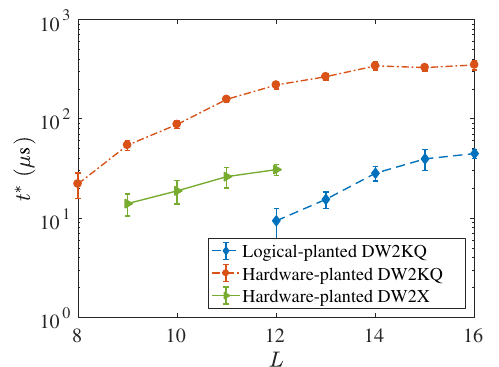
FIG. 16. Scaling of t (cid:3) with problem size for the two problem classes. Error bars represent the 95% confidence interval for the location of t (cid:3) by fitting to a quadratic function as described in Appendix